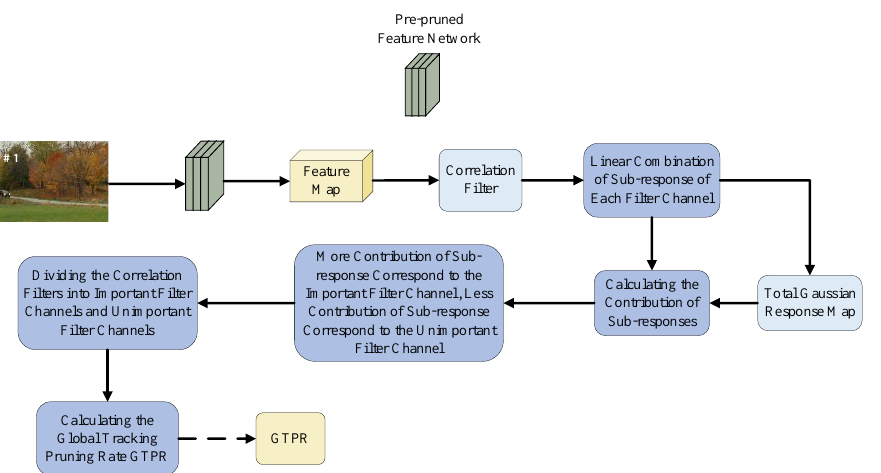
Figure 3. Optimal determination of global tracking pruning rate based on tracking response contri- bution. ( #𝑖 indicates the 𝑖 𝑡ℎ picture in the video sequence).